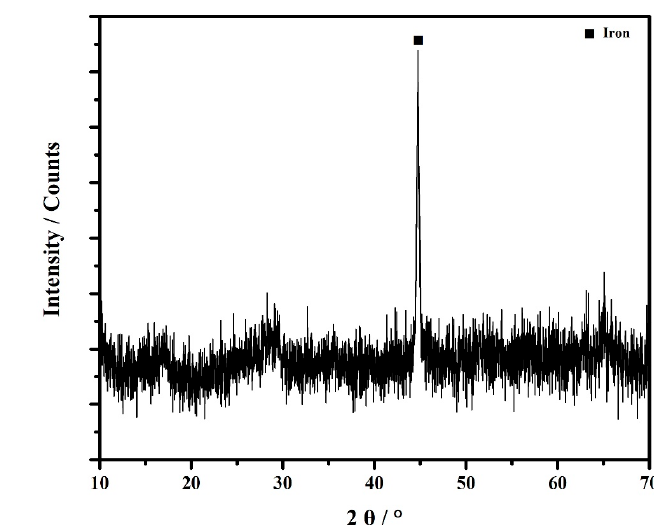
Figure 11. The XRD pattern of DRI product. Table 4. Chemical component of DRI product (wt.%).